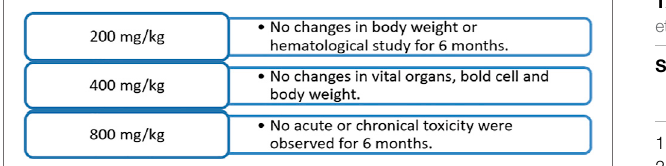
FIGURE 10 | Toxicology study of shikonin on adult Wistar rats (Su et al., 2014).